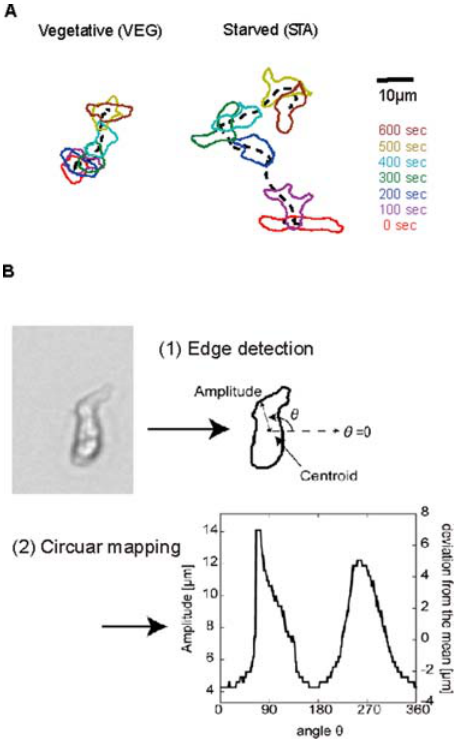
Figure 1. Morphological dynamics of individual cells during spontaneous cell migration. (A) Typical time-lapse images of a wild- type vegetative (WT VEG) cell and a wild-type starved (WT STA) cell. The periphery of a single cell is obtained from a binarized image. (B) Summary of Image processing. (1) edge detection and (2) circular mapping of Amp ( h ,t ). We define Amp ( h ,t ) (left ordinate) as the radial distance from the centroid to the membrane edge in the direction h and at time t. Amp ( h , t ) that is defined as Amp ( h ,t ) 2 Æ Amp ( h ,t ) æ h represents the deviation of cell shape from the average (right ordinate).